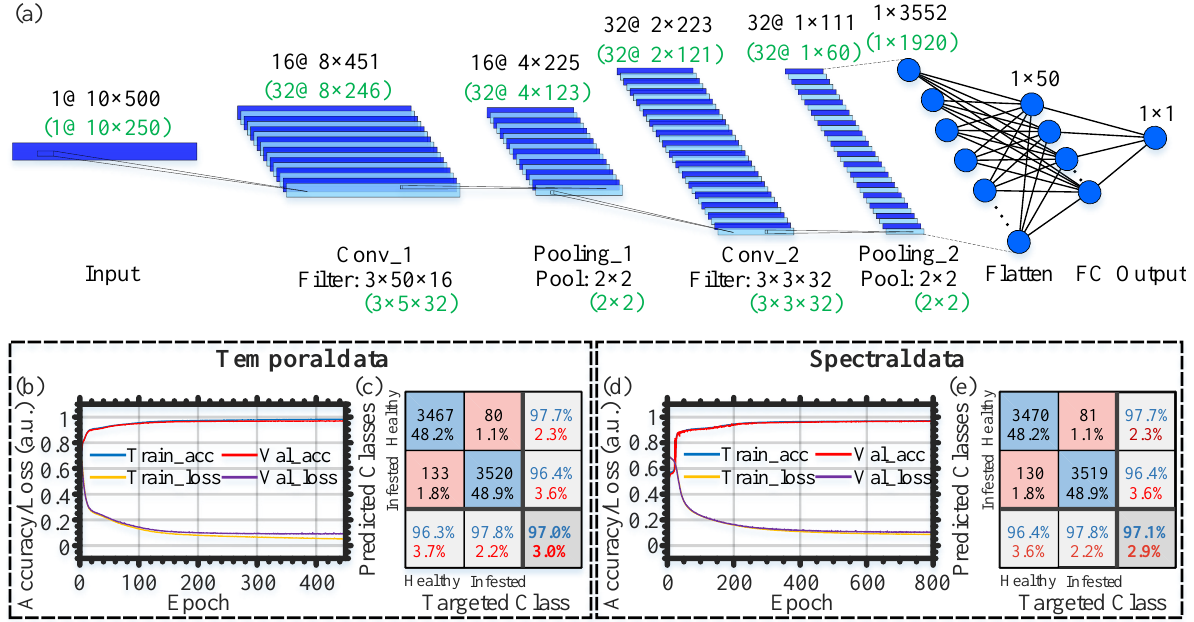
Figure 4. ( a ) The CNN architecture for classifying “infested” and “healthy” temporal (spectral) signals. Conv: convolutional; FC: fully-connected; The dimensions of the CNN architecture associated with the spectral data are written in green. Training and validation history ( b , d ) and confusion matrix ( c , e ) when using the temporal/spectral